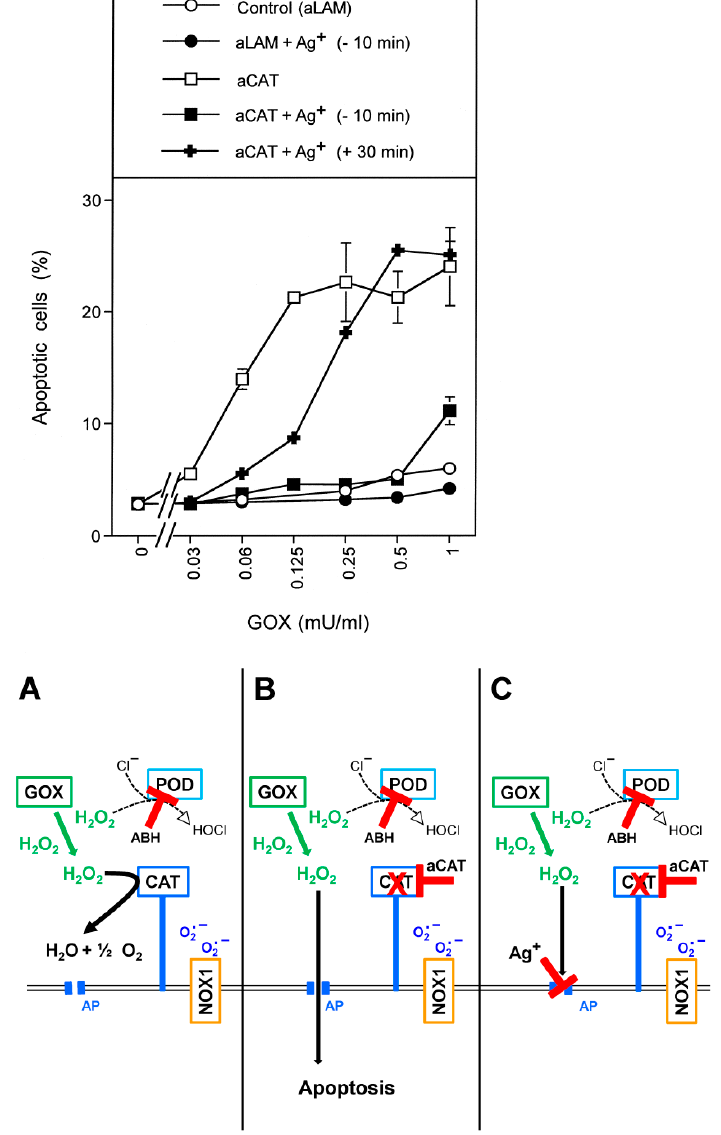
Figure 1. Apoptosis induction in MKN-45 gastric carcinoma cells by exogenous H 2 O 2 is controlled by membrane-associated catalase and aquaporins. 5000 MKN-45 cells in 96 well plates with 100 µ L complete medium were treated with 0.2 µ g/mL control antibody (anti-laminin = aLAM) or neutraliz- ing antibody directed towards catalase (aCAT) for 20 min at 37 ◦ C before the indicated concentrations of H 2 O 2 -generating GOX were added. In addition, where indicated, 5 µ M of aquaporin-inhibiting AgNO 3 was added either 10 min before GOX addition (“ − 10 min”) or 30 min after GOX (“+30 min”). All assays were in duplicate and contained 150 µ M of the peroxidase inhibitor ABH to prevent HOCl synthesis. The percentages of apoptotic cells were determined 1.5 h after addition of GOX. The results show that apoptosis induction was dependent on the concentration of GOX, required the inhibition of membrane-associated catalase (as it was effective with anticatalase but not with antilaminin) and was mediated by aquaporins (as it was inhibited by silver ions). Late addition of silver ions only prevented apoptosis induction by low concentrations of GOX. Statistical analysis: Apoptosis induc- tion mediated by GOX concentrations of 0.19 mU/mL and higher were highly significant ( p < 0.001). Inhibition of GOX-mediated apoptosis induction by Ag + was highly significant ( p <